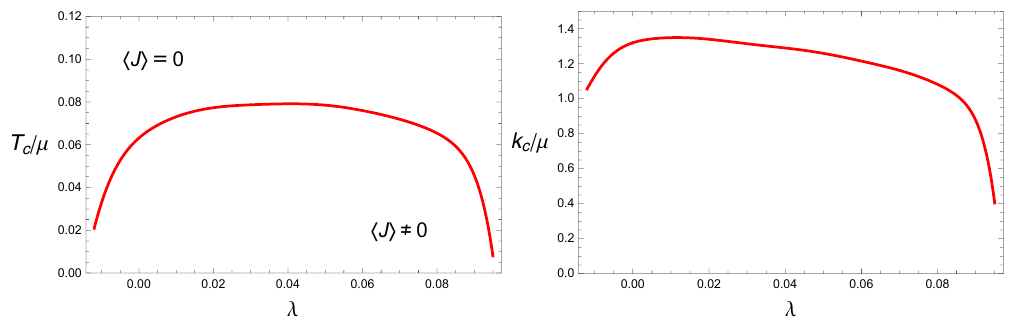
Figure 5 . The critical temperature T c =(cid:22) ( left ) which is the onset of the spatially modulated phase transition and the corresponding critical momentum k c =(cid:22) ( right ) for di(cid:11)erent (cid:21) when (cid:11) ’ 0 : 213.